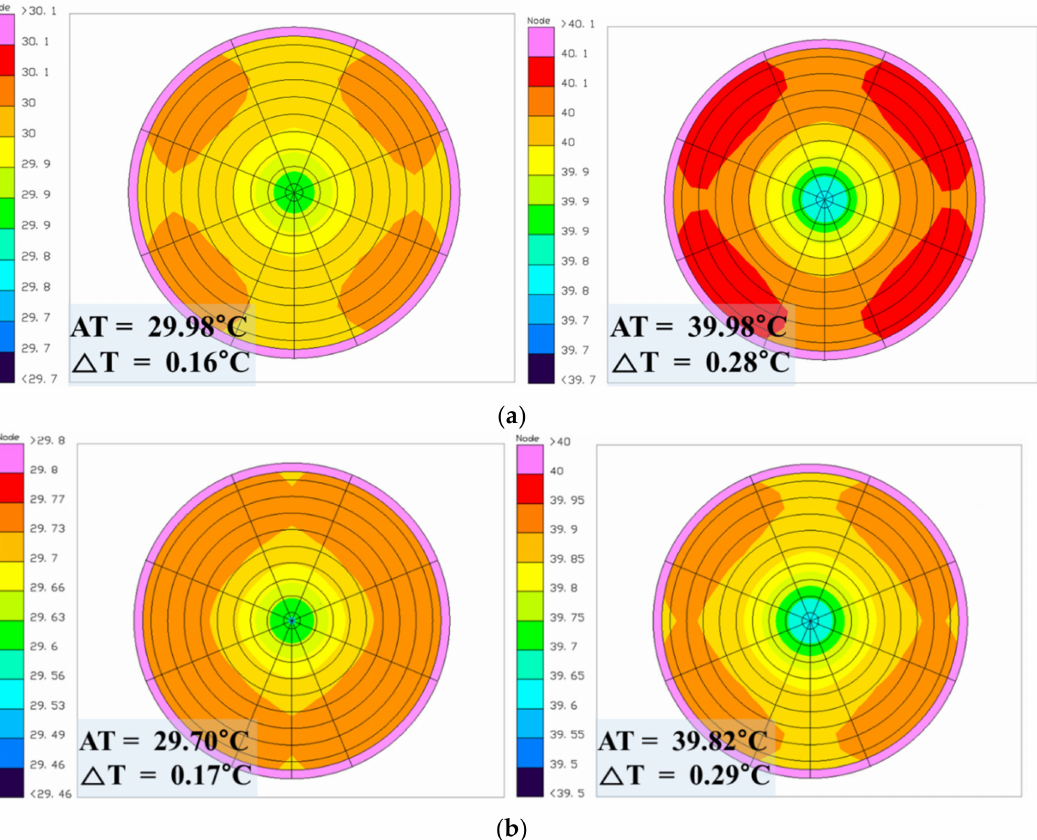
Figure 7. Temperature distribution on BB surface in heating range at heat pipe normal operation condition. ( a ) Worst hot case; ( b ) worst cold case; AT: average temperature of BB surface; ∆ T: temperature gradient on BB surface.